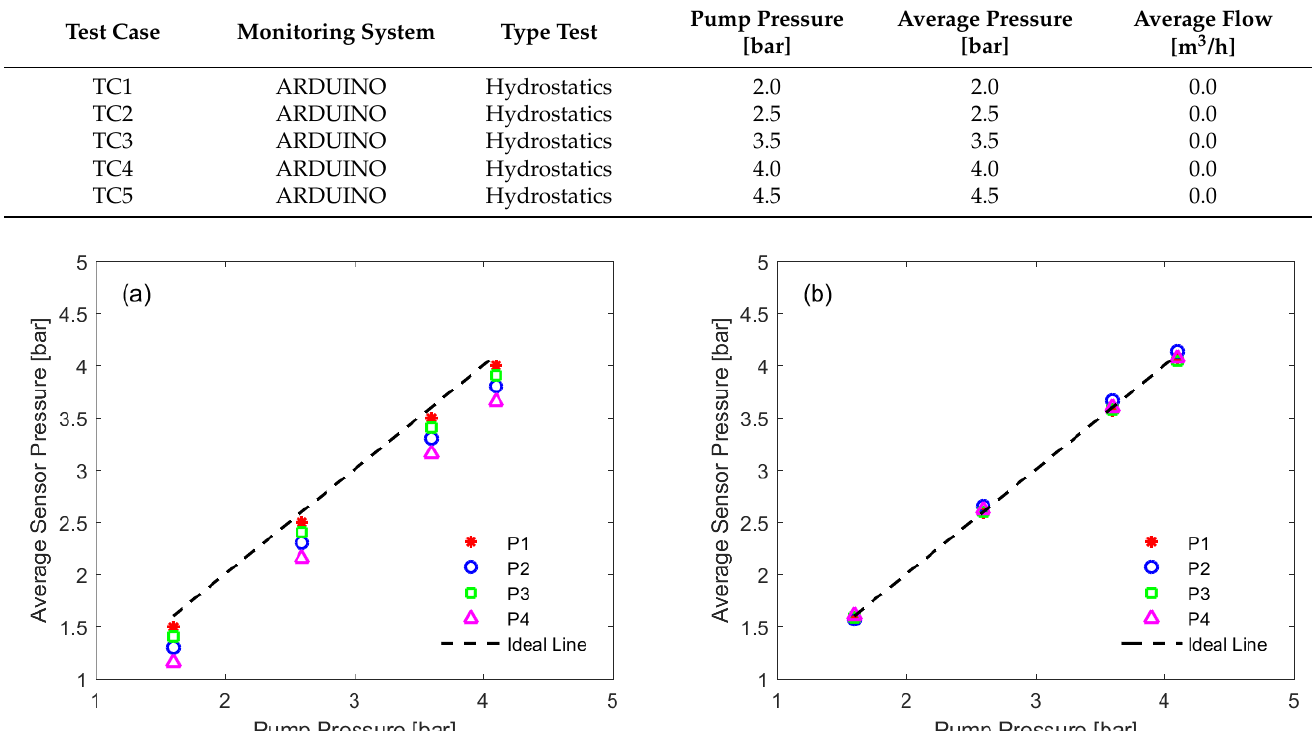
Table 1. Hydrostatic pressure experiment for the calibration of the pressure cells connected with Arduino system. Test Case